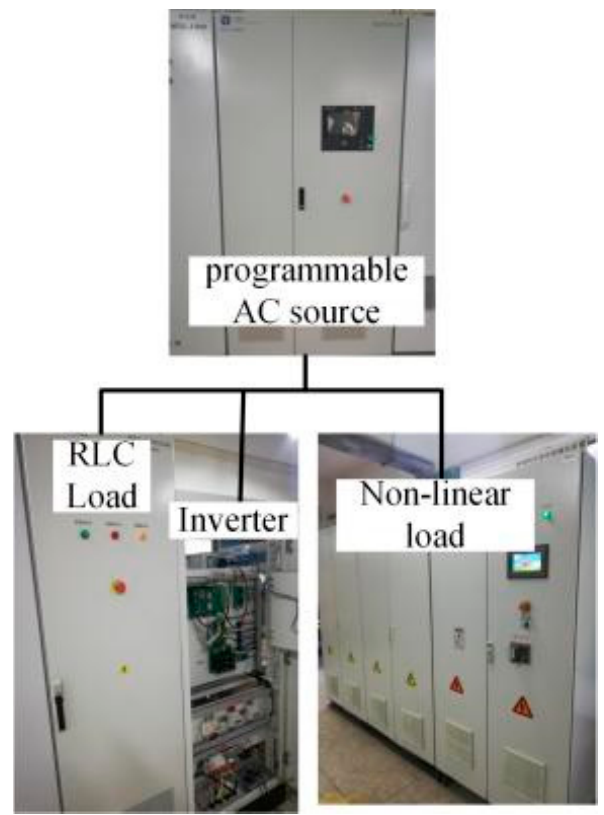
Figure 12. Experimental prototype developed in the laboratory.